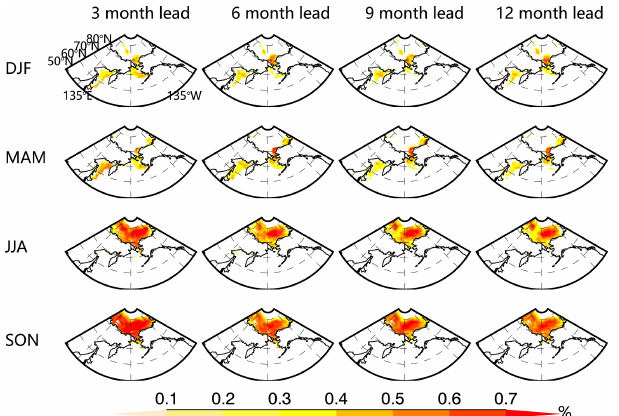
Figure 8. The prediction skill of the regional Markov model com- pared against that of anomaly persistence and climatology averaged over the model domain as a function of the number of months of lead